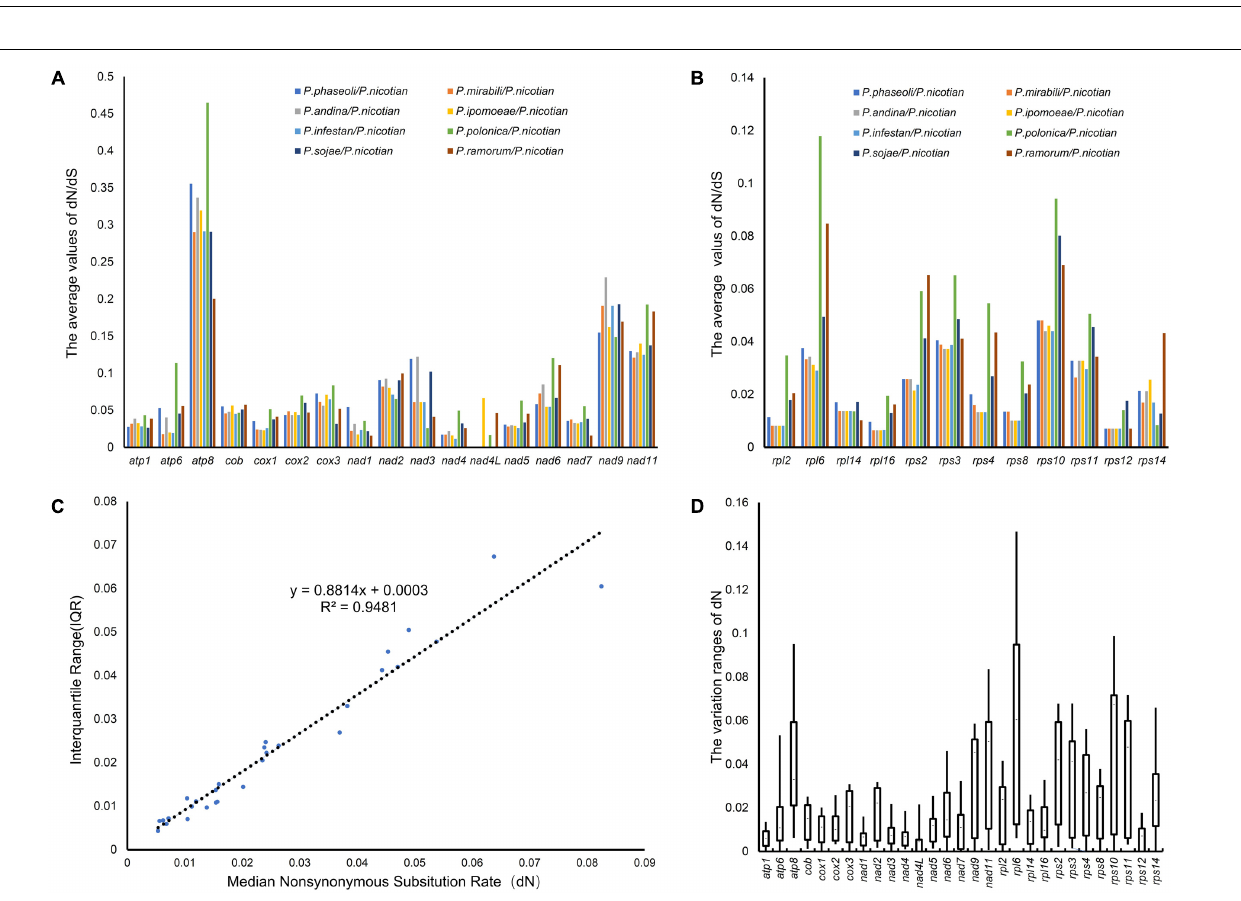
FIGURE 6 | Evolutionary rates of common genes in the Peronosporales. (A,B) dN/ds ratio of pair-wise comparison among the nine species in the Peronosporales. (C) dN values and their standard deviations. (D) The Box-plot of dN values.